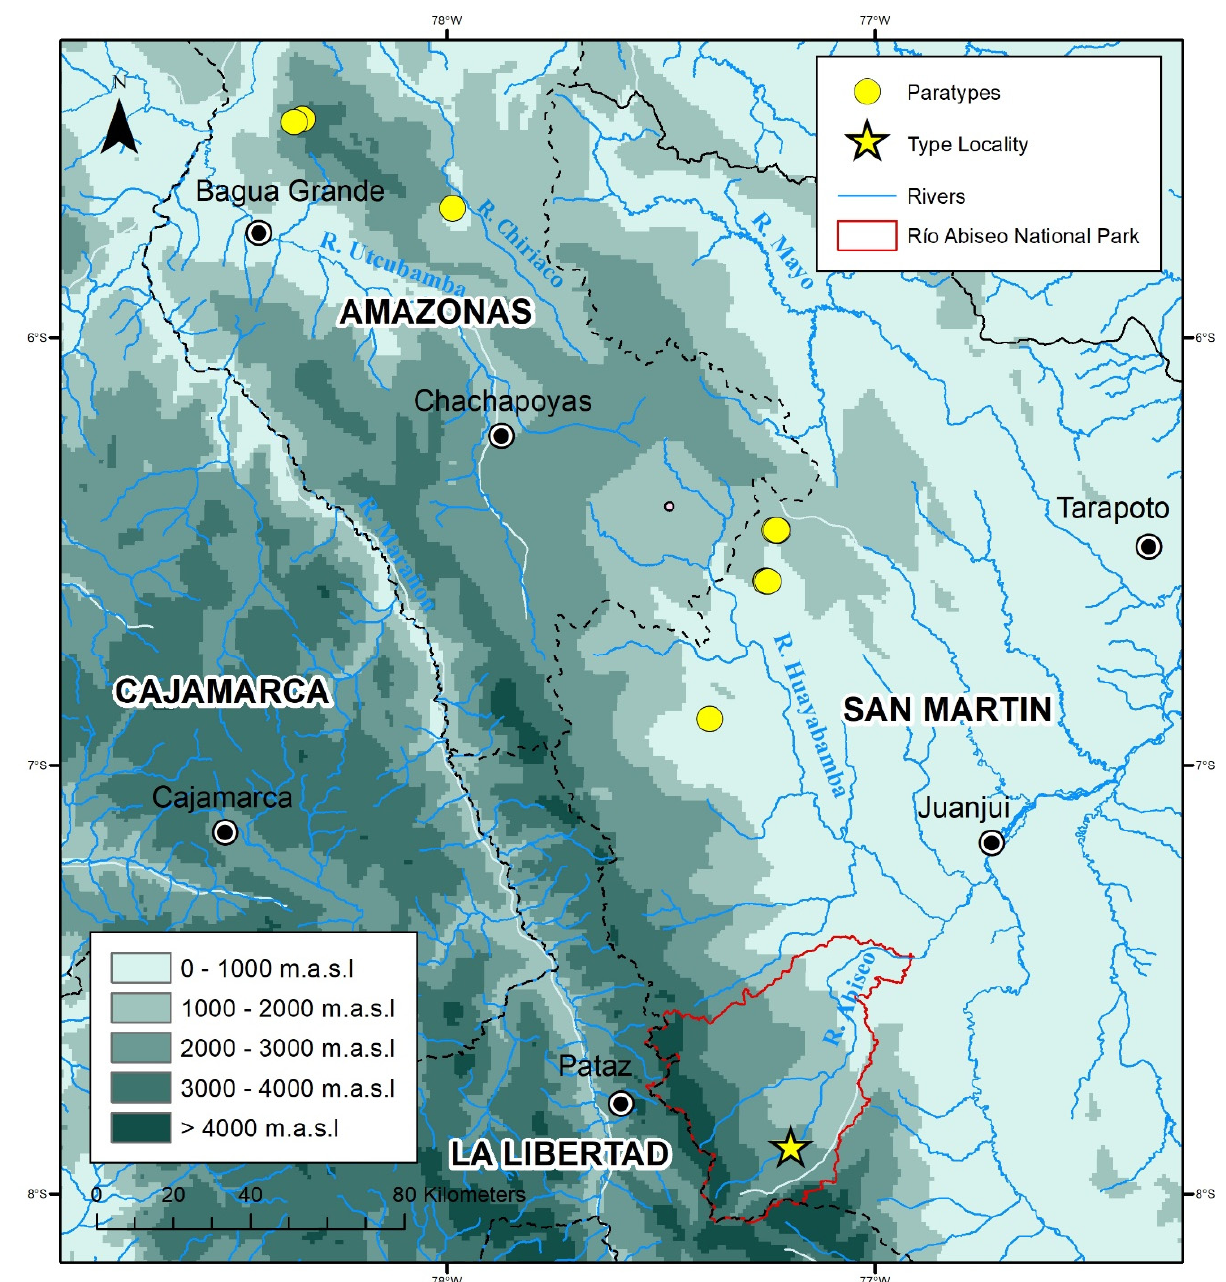
Figure 2. Map with the distributional records of Rhinella moralesi sp. nov. in Departamentos Amazonas and San Martín. GIS Map by J.C. Cusi.